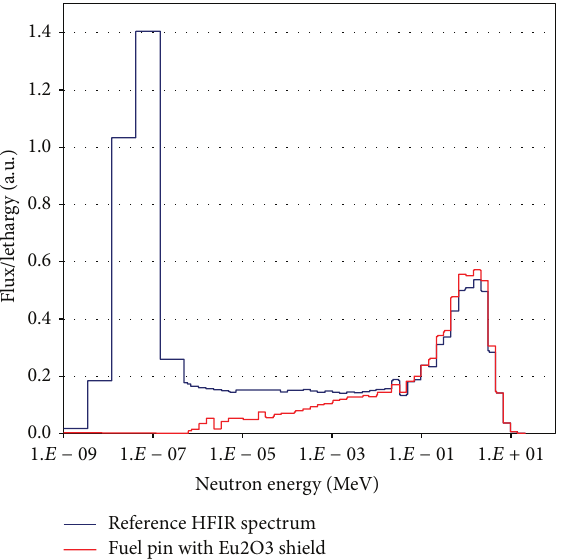
Figure 26: Neutron flux spectra within the FT region of HFIR and the tri-pin fast irradiation facility